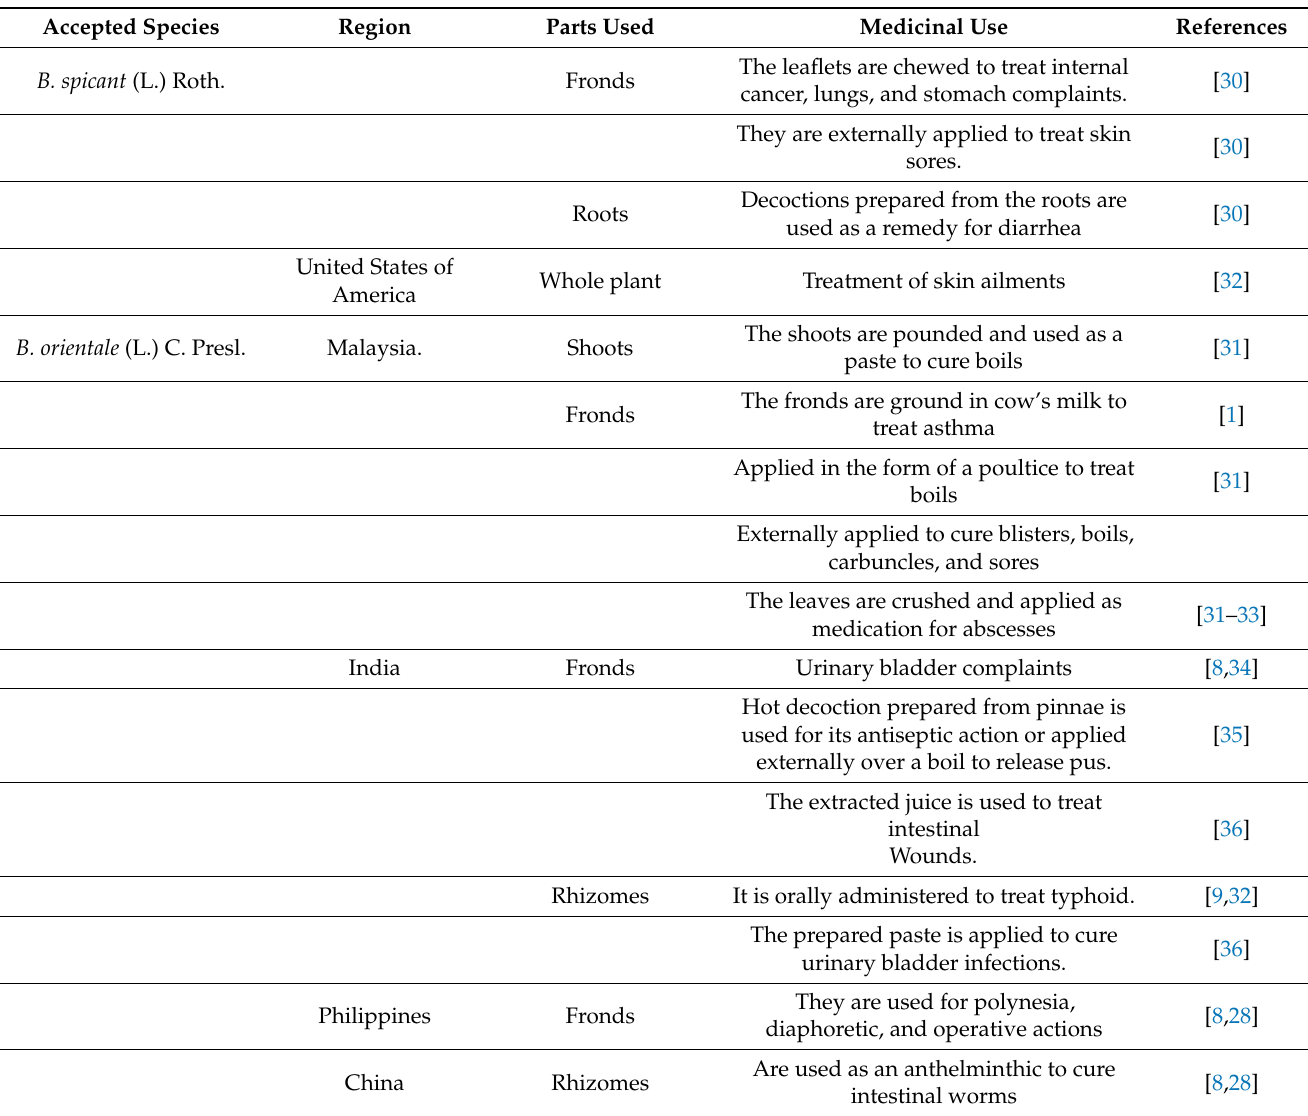
Table 1. Traditional medicinal uses of the Blechnum